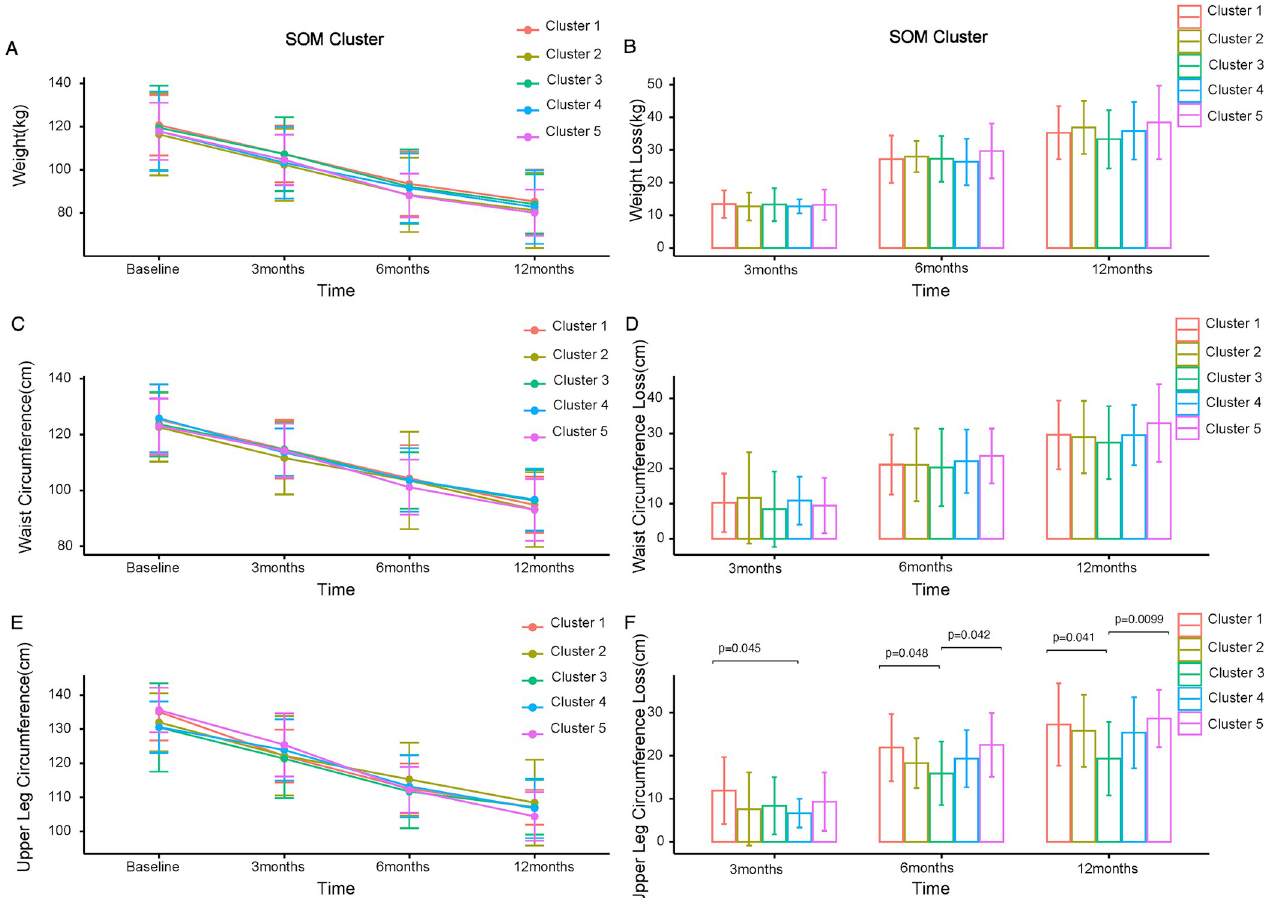
Fig 5. Weight and fat loss progression at distinct time points after bariatric surgery for the five defined SOM clusters (metabotypes). (A) Weight (kg) of BARIA individuals at baseline, three months, six months and one year after bariatric surgery for each metabotype. (B) Weight loss(kg) of BARIA individuals at baseline, three months, six months and one year after bariatric surgery for each metabotype. (C) Waist circumference (cm) of BARIA individuals at baseline, three months, six months and one year after bariatric surgery for each metabotype. (D) Reduction of waist circumference(cm) of BARIA individuals at baseline, three months, six months and one year after bariatric surgery for each metabotype. (E) Upper leg circumference (cm) of BARIA individuals at baseline, three months, six months and one year after bariatric surgery for each metabotype. (F) Reduction of upper leg circumference(cm)of BARIA individuals at baseline, three months, six months and one year after bariatric surgery for each metabotype. Statistical significance among metabotypes is calculated with t-test and adjusted with FDR; the symbols indicating significance among metabotypes are ‘ � ’: P < = 0 . 05 , ‘ �� ’: P < = 0 . 01 , ‘ ��� ’: P < = 0 . 001